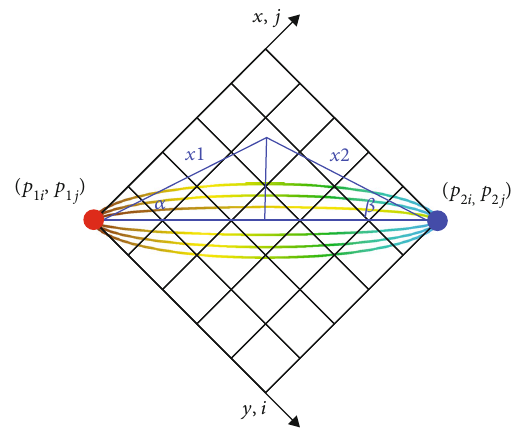
Figure 1: Characterization method of interwell connectivity parameters in heterogeneous reservoirs based on fl ow tube method.